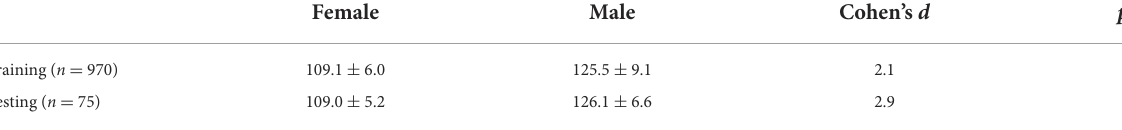
TABLE 3 Grip strength scores by sex.